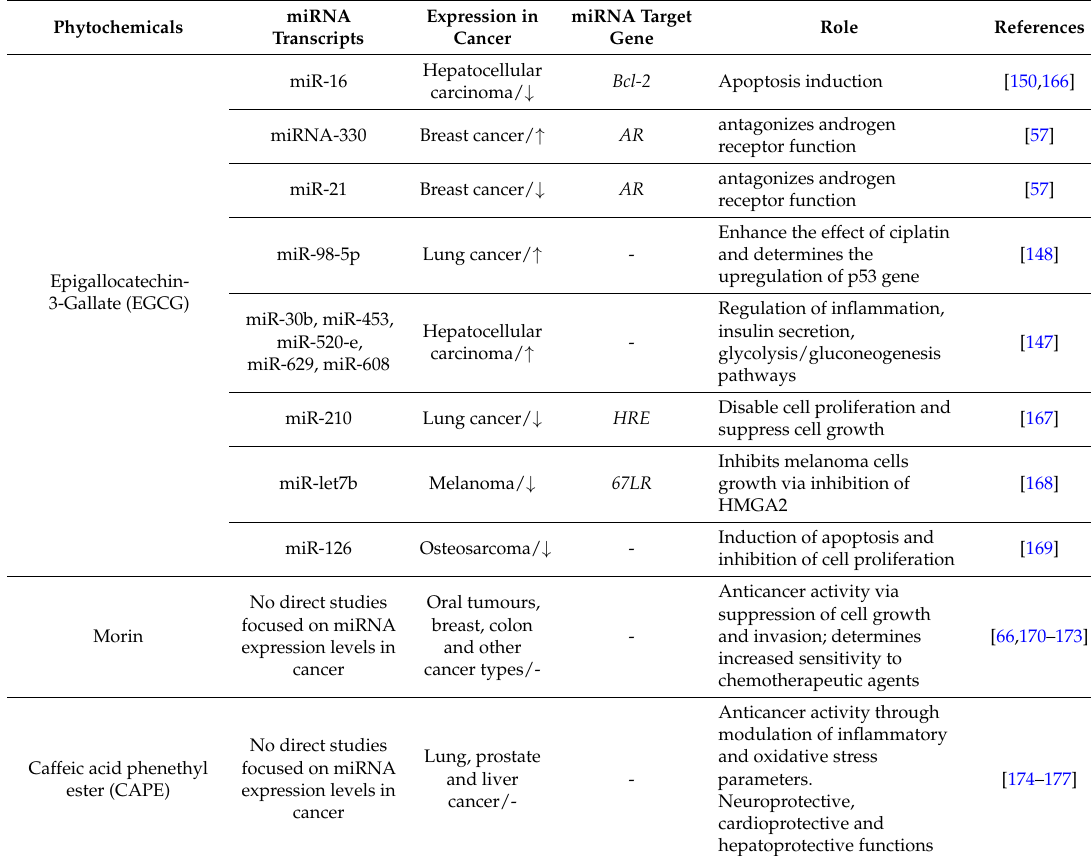
Table 2. Target miRNAs for different phytochemicals in cancer and their capacity to modulate the expression level of some relevant target genes (overexpression: ↑ or downregulation: ↓